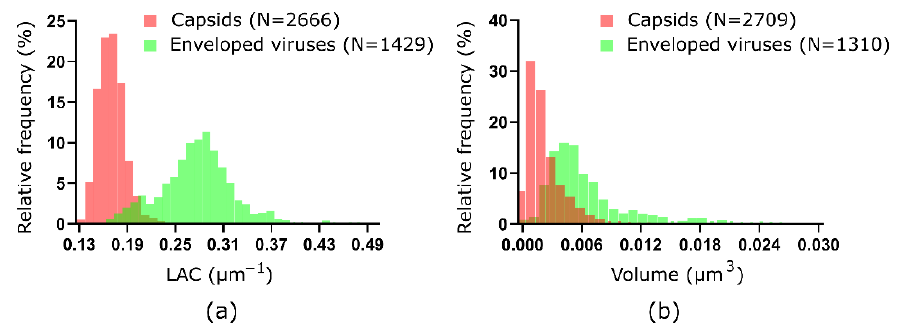
Figure 3. Quantitative analysis of nucleocapsids and secreted viruses of HSV-1. ( a ) Distribution of SXT LAC values for capsids (red) and enveloped viruses (green) based on blob detection. ( b ) Distribution of volume for capsids (red) and enveloped viruses (green) based on blob detection of the SXT volume.